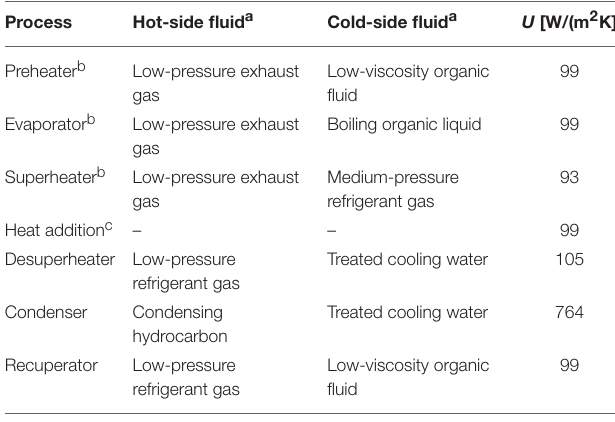
TABLE 1 | Optimal parameter values that minimize the AAD between the turbine model and Figure 2 . η max δ/ b av,ref